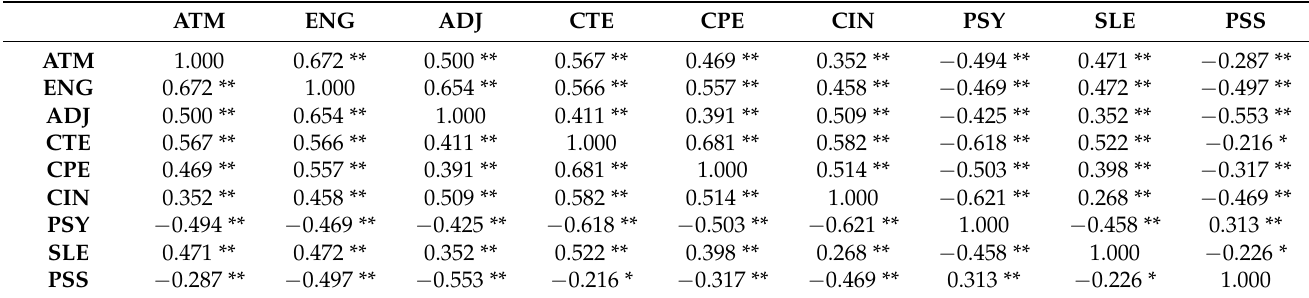
Table 3. Relationships between research